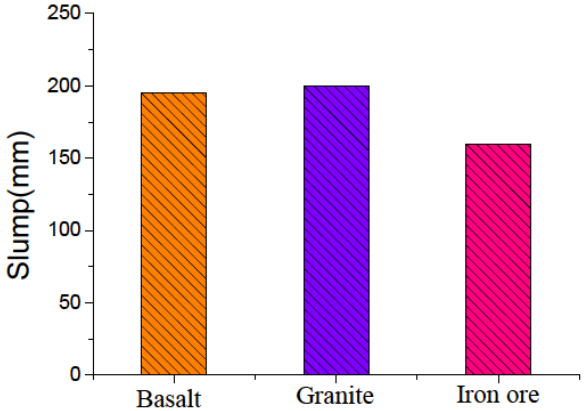
Figure 1: Influence of aggregate type on workability